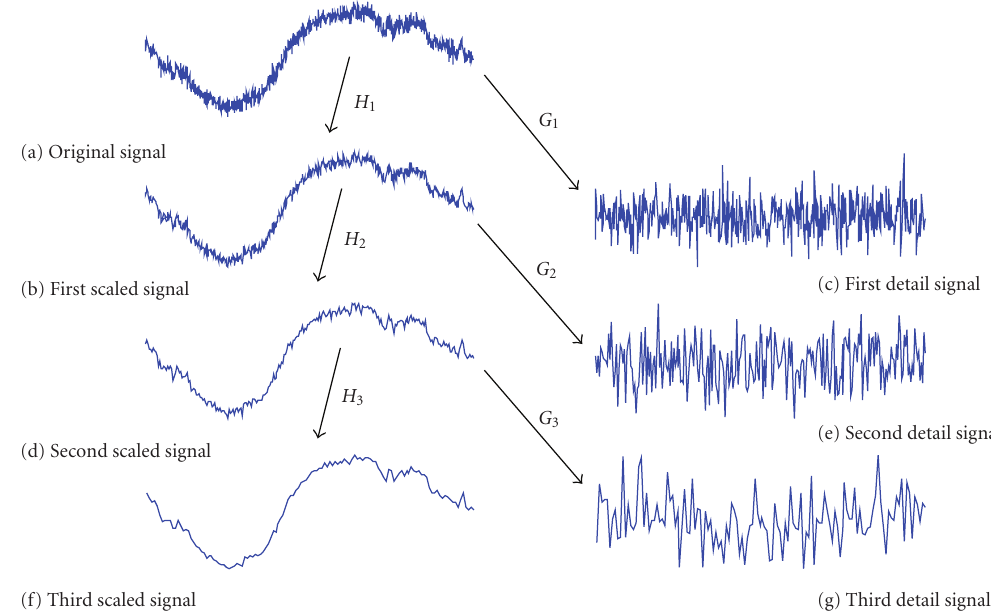
Figure 1: A schematic diagram of data representation at multiple